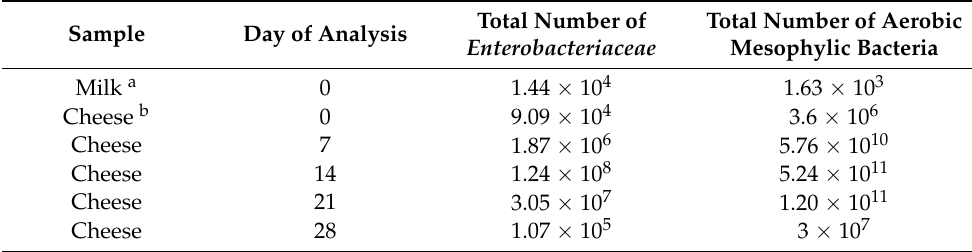
Table 3. Total number of Enterobacteriaceae and aerobic mesophylic bacteria in goat’s milk and cheese during